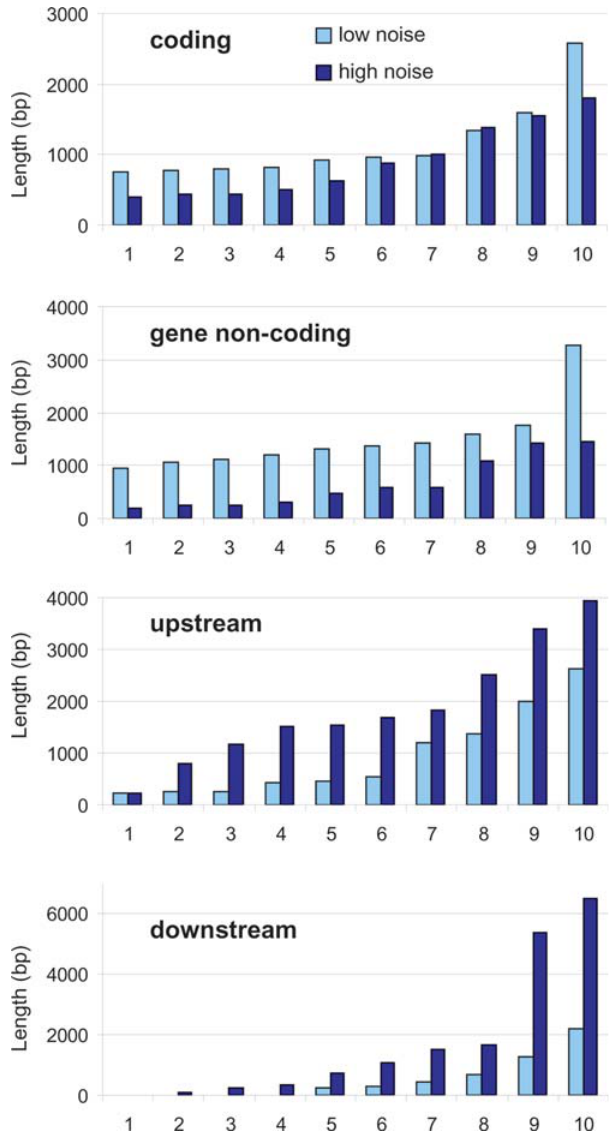
Figure 6. Examples of genetic sequence lengths and expres- sion values for genes with low and high noise. The genome-wide trends that we observe can also be noticed at the level of individual genes, higher noise genes having a tendency for having longer intergenic sequences, shorter gene noncoding and, to a lesser extent, shorter coding sequences. Genes were ordered by increasing noise (replicate variability) value and sets of ten consecutive genes were randomly selected around the ends of the range of values seen in Figure 4E–H. For each category here the values are ordered. The low- noise genes are: AT4G02610, AT5G61580, AT2G36390, AT5G64470, AT5G26210, AT2G45990, AT2G25670, AT2G36530, AT5G66380, AT5G35530, and the high-noise: AT2G45760, AT4G17220, AT1G70830, AT1G29500, AT2G22760, AT4G24700, AT3G13640, AT1G62560, AT1G60870, AT1G68590. See the Supplementary Figure for examples with tissue variability and median expression. doi:10.1371/journal.pone.0003670.g006 tissue variability, and median expression, and compared the intergenic and gene sequence lengths in the low and high sets. As expected from the relationships in Figure 4, we found that genes with higher noise or tissue variability generally have longer intergenic sequence lengths and smaller gene noncoding sequence